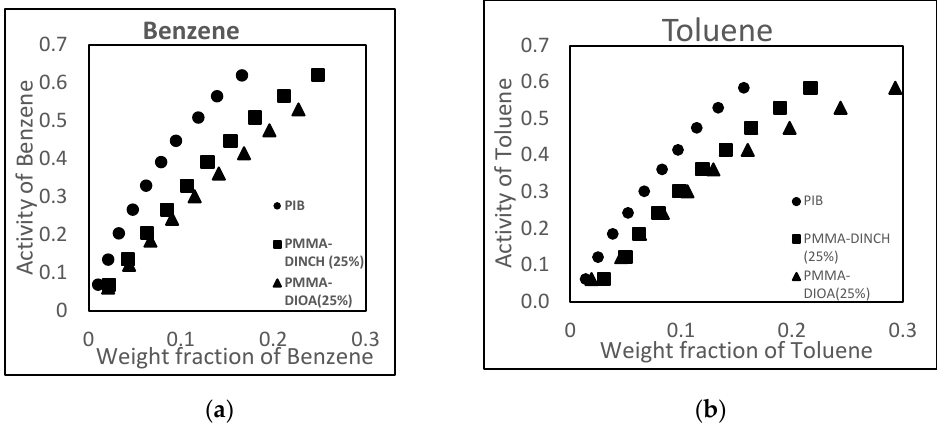
Figure 1. Comparison between sorption of benzene ( a ) and toluene ( b ) in a commonly used rubbery polymer, PIB, and two plasticized PMMA films.